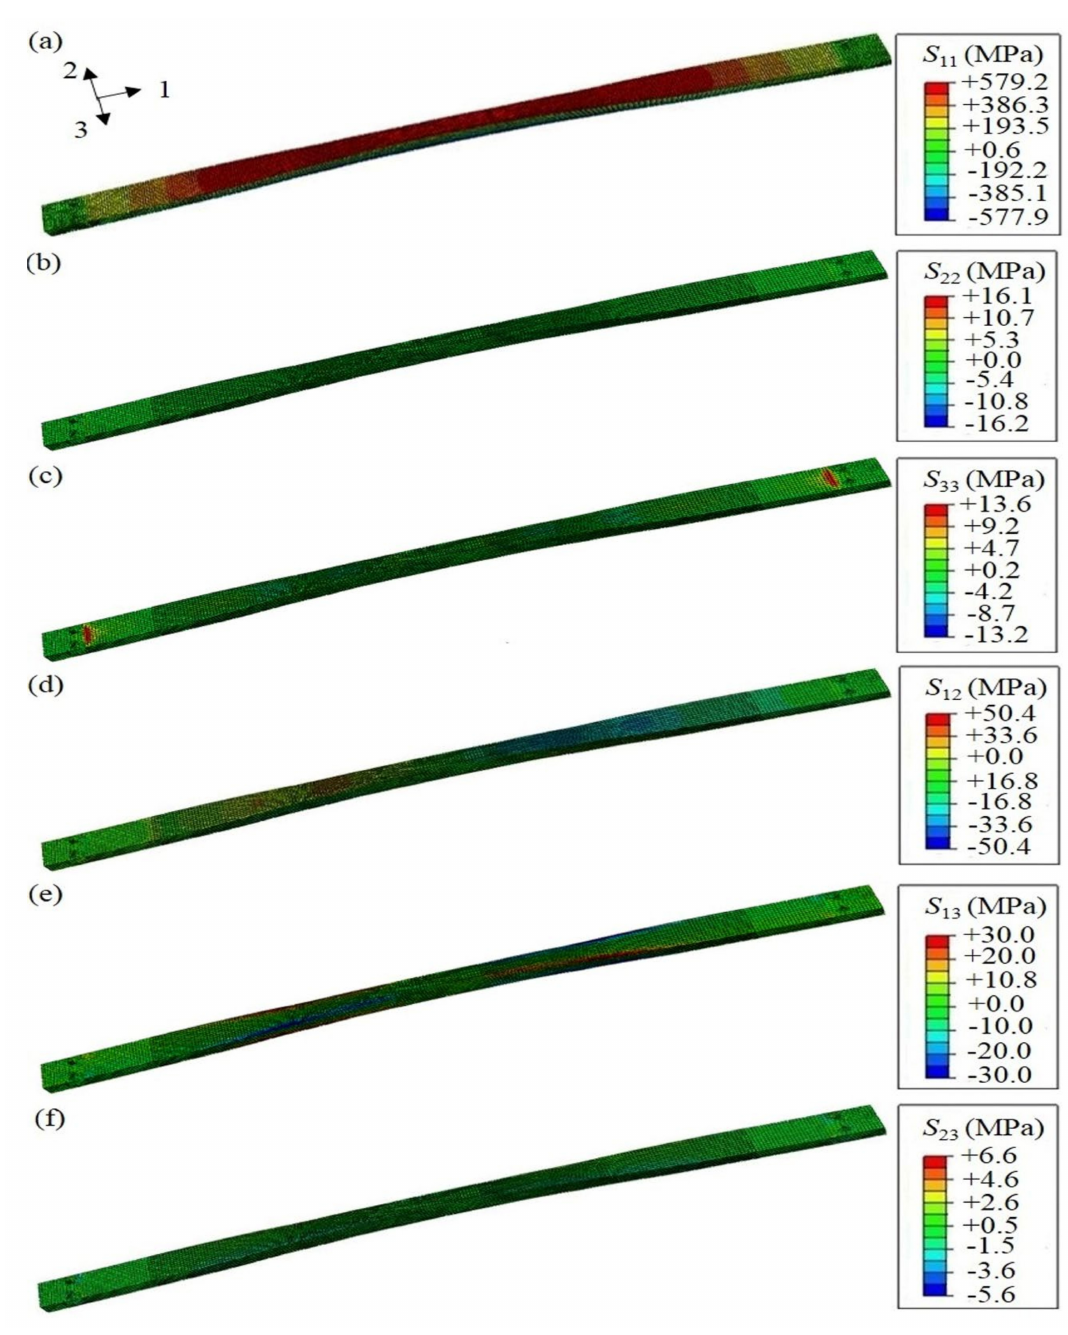
Figure 8. Stress distribution along all directions of the composite leaf spring under full loading condition: normal stress of ( a ) length direction S 11 , ( b ) thickness direction S 22 , and ( c ) width direction S 33 ; shear stress of ( d ) length-thickness direction S 12 , ( e ) length-width direction S 13 , and ( f ) thickness-width direction S 23